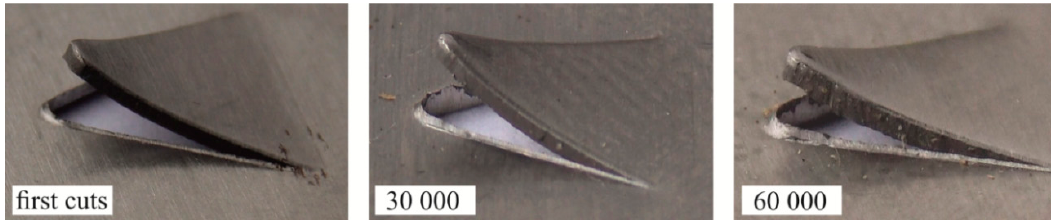
Figure 14. The burr on the edge of the sheet for exemplary hooks cut out with a clearance of 5%.